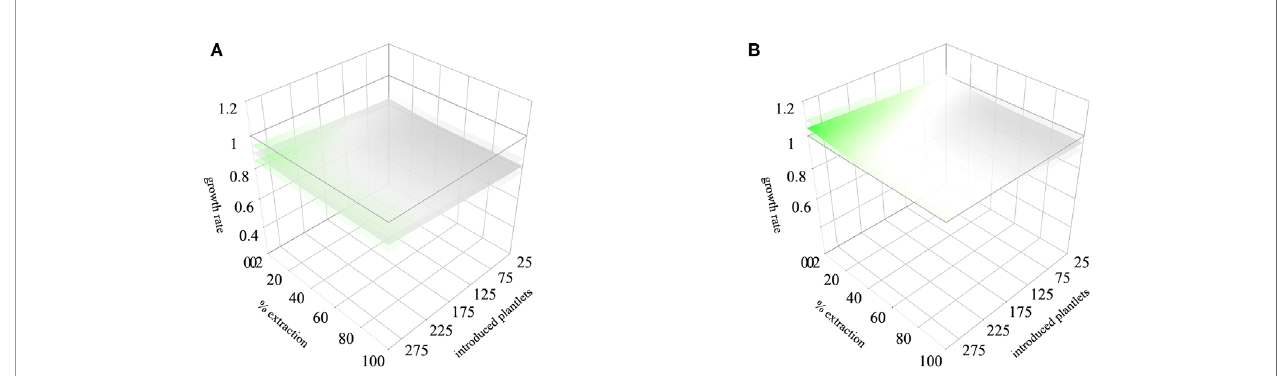
FIGURE 6 | Integrated stochastic rainfall models for the two monitored periods ( fi rst and second years of the study, respectively. The scenario (A) corresponds to the fi rst monitored period and scenario (B) corresponds to the second monitored period. Lower and upper lambda responses to the lower and upper rainfall thresholds are represented in shaded sheets. Lower l values are in gray, and higher